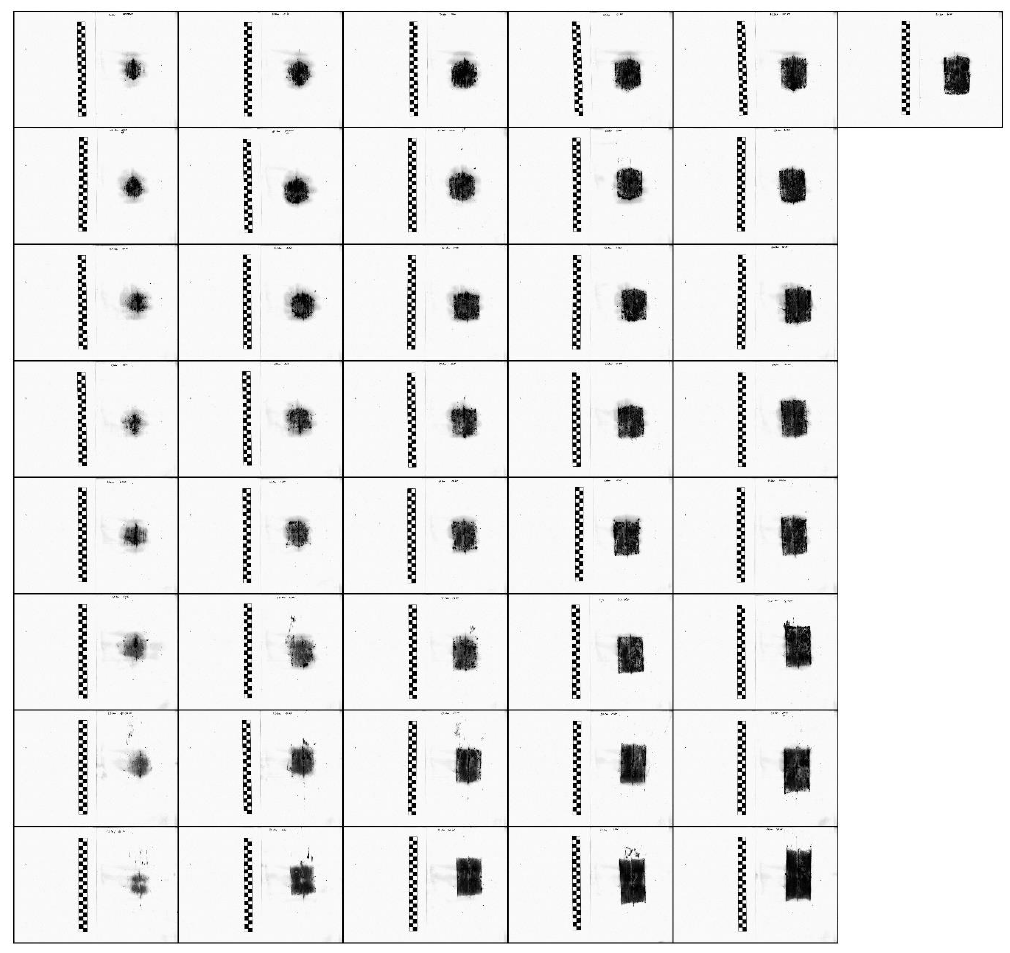
Figure 12. Negatives of wheel-to-surface contact areas for the ASFT tester wheel (ASTM smooth tire). Each of the scanned negatives of the tire contact trace with the pavement was outlined in the AutoCAD envelope. Then, the surface area of the geometric figure thus formed was calculated. An example of an envelope is shown in Figure 13. The envelopes were created several times for the same circle and measurement conditions, and the results were averaged. The results for aircraft tires are collected in Tables 3 – 4, while ASFT testers tires — in Tables 5 – 6. On the contrary, Figures 14 – 17 show the relation between the aircraft wheels-surface contact surface and the pressure force. Each graph presents a different wheel pressure value. Each chart shows the results of tires testing from PZL M28 and Su-22 aircraft and the corresponding theoretical values calculated using Formulae (3) and (4). Values corresponding to those calculated from Formula (3) are marked on the graph as P/p (equation), while obtained from Formula (4) as [aircraft type] (equation). The wheel diameter of the PZL M28 plane is 72 cm, while the Su-22 plane — 88 cm, and such values were taken for calculations.